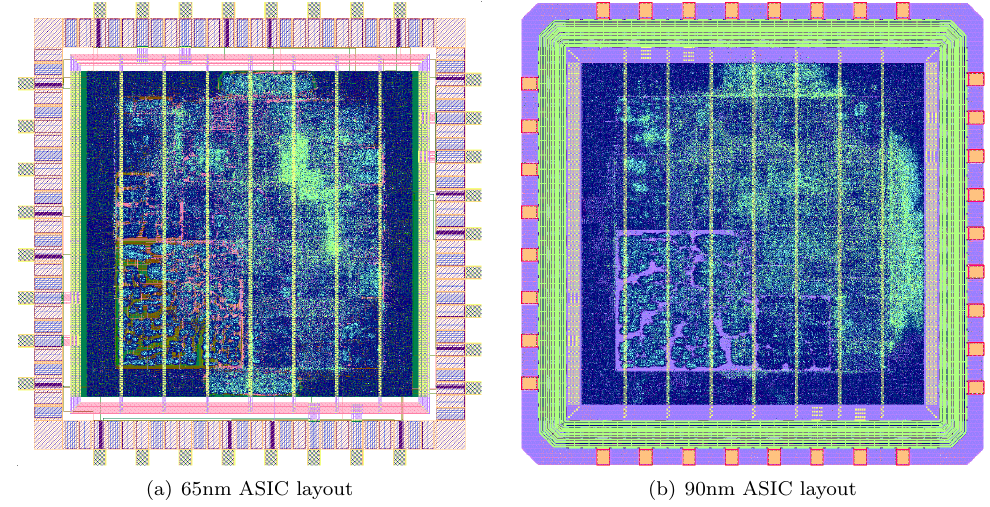
Figure 1: Layout of the ASIC